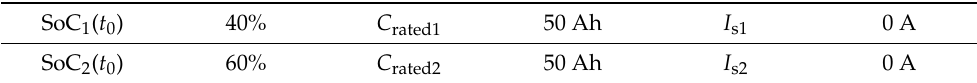
Table 1. Battery parameters for SoC estimation.